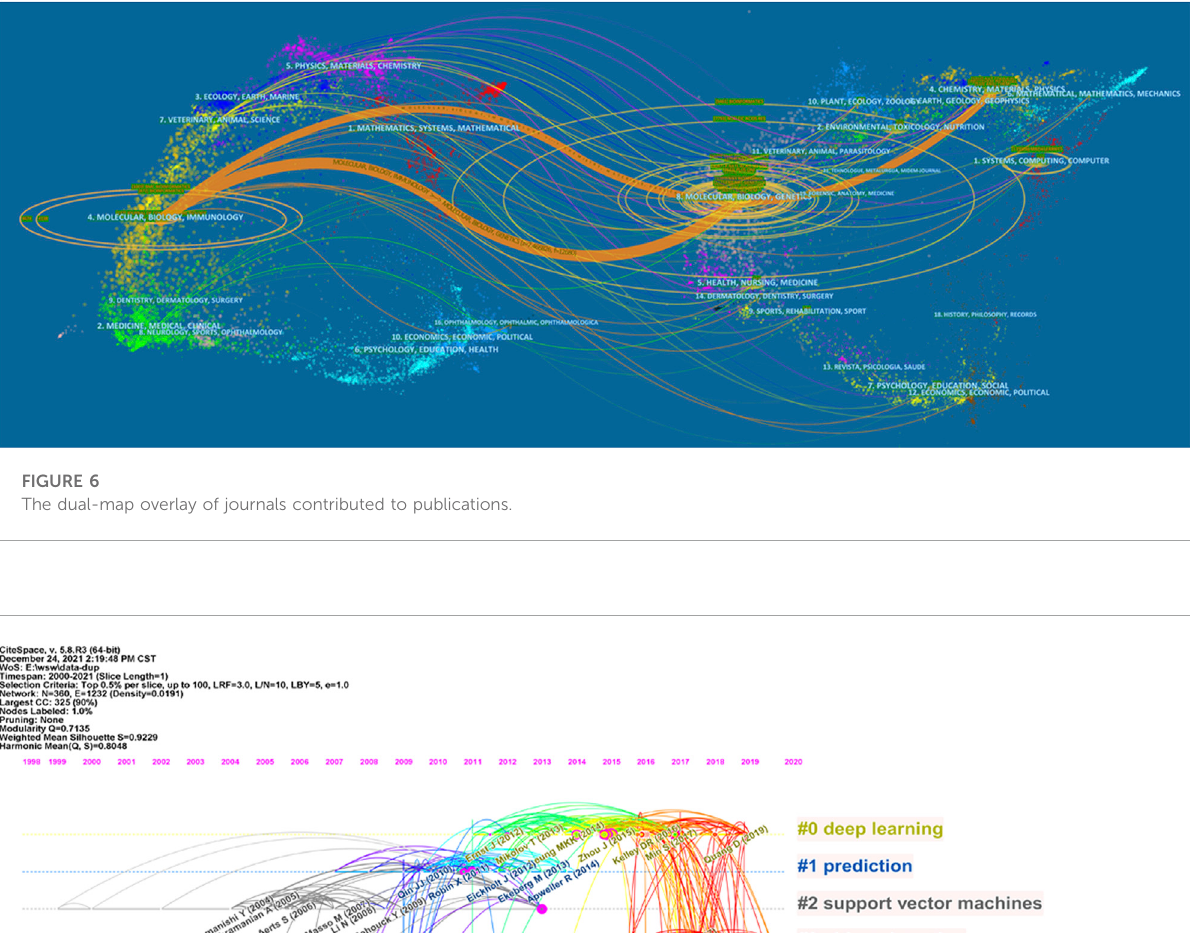
FIGURE 7 Reference co-citation map of publications on ABAM from 2000 to